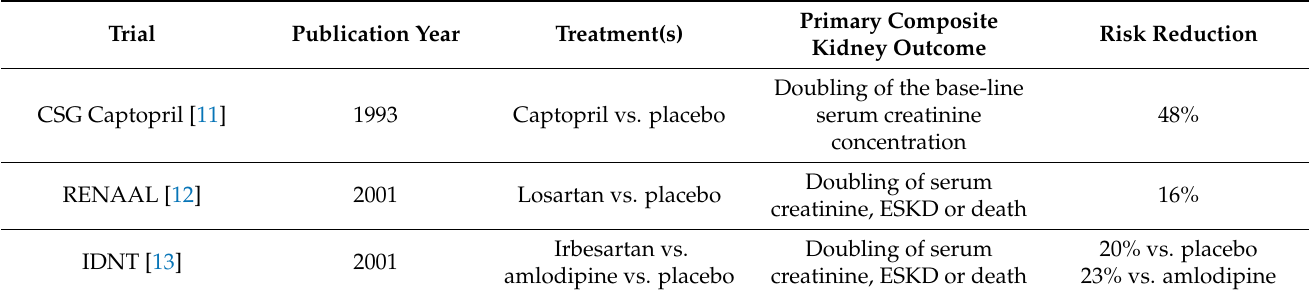
Table 1. Summaries of landmark trials with the RAAS